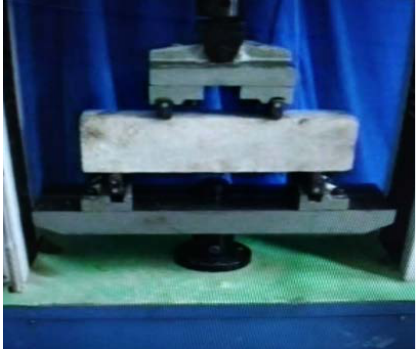
Figure 5. Picture of the flexural loading concrete. A scanning electron microscope (SEM) was used on the above 28 day old specimens. After the cube compressive strength test, the interface between the cement paste and aggregate was selected from the fragments, and the observation surface of the samples was required to be as flat, small, and thin as possible, of which the maximum did not exceed 1 cm 3 . After being pumped to the vacuum state, the surface was sprayed and placed under SEM. The surface morphology of the samples was observed by JSM-7500F in a cold field (accelerated voltage: 5